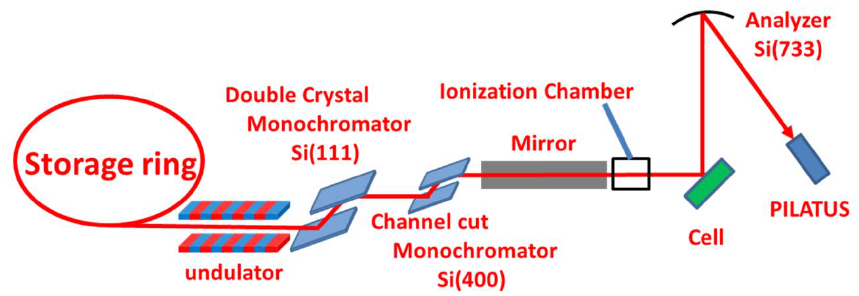
Figure 1. The optics of high energy resolution fluorescence detection X-ray absorption spectroscopy (HERFD-XAS) experiment at the BL11XU beamline in SPring-8.